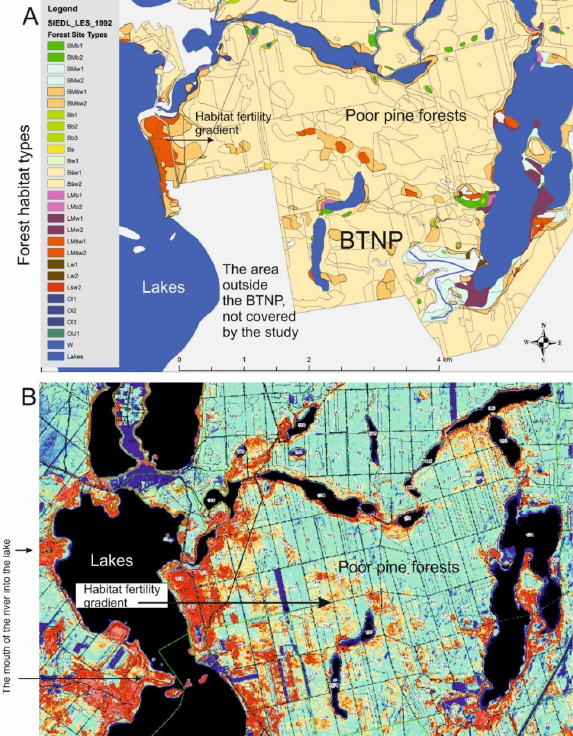
Figure 9. Variation of the trophic nature of forest habitats according to the map of forest habitats prepared using the traditional method ( A ) and on the basis of the NDVI ( B ). Red color in ( B ) correlates to zone of more fertile habitats presented in ( A ) (LM´sw—deciduous-coniferous mixed forests; BM´sw—coniferous- deciduous mixed forests).